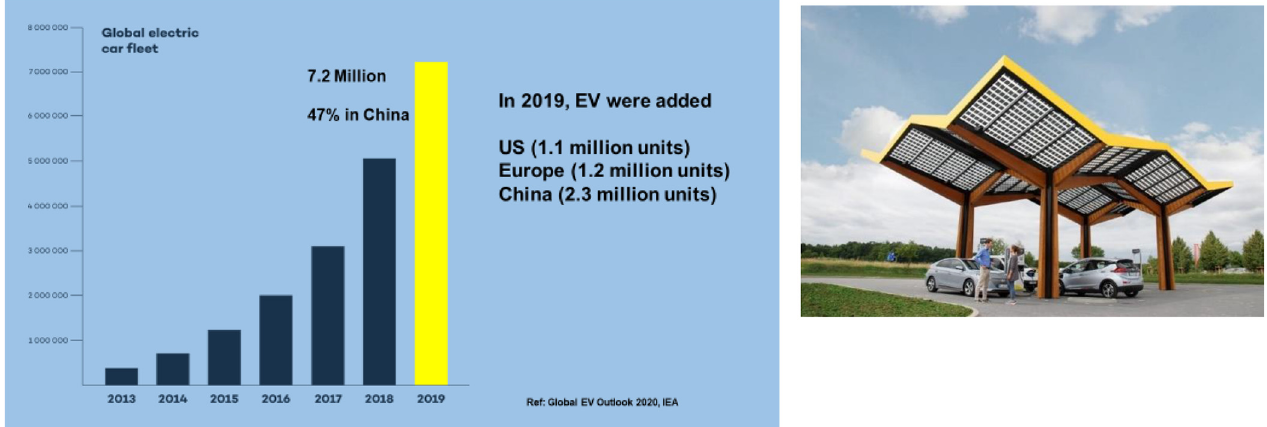
Fig. 27. Global offshore Wind Capacity in three Regions 2009 – 2019.